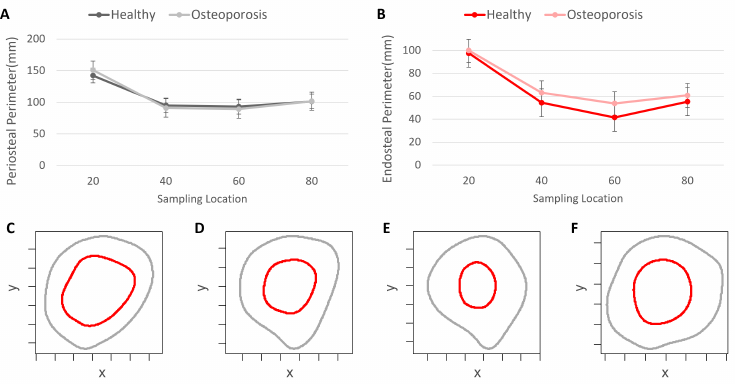
Figure 2. Perimeter data from the healthy and osteoporosis experimental groups. ( A ) Periosteal perimeter data. ( B ) Endosteal perimeter data. ( C ) Periosteal and endosteal perimeters at 80% biomechanical length (BL). ( D ) Periosteal and endosteal perimeters at 60% BL. ( E ) Periosteal and endosteal perimeters at 40% BL. ( F ) Periosteal and endosteal perimeters at 20% BL. Cross-section perimeter examples from a healthy